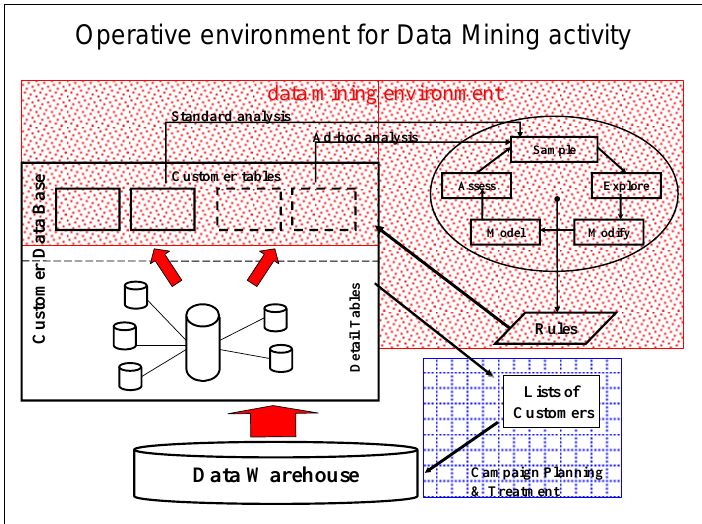
Figure 2: Operative Environment for Data Mining